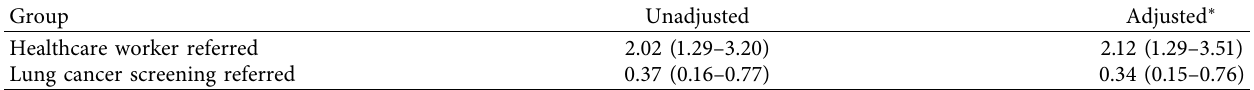
Table 4: Logistic regression with imputed